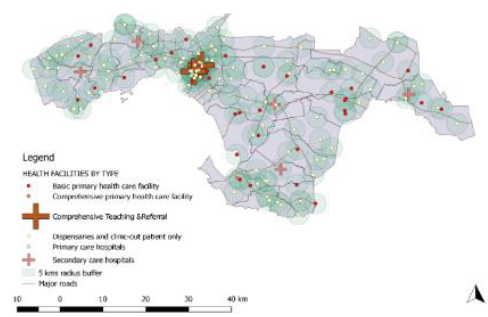
Figure 2: Health facilities by level of